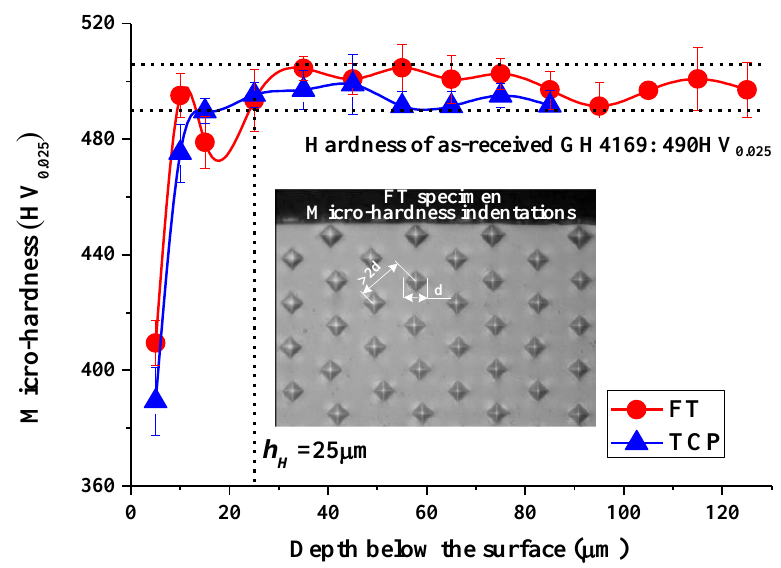
Figure 6. Microhardness distributions.